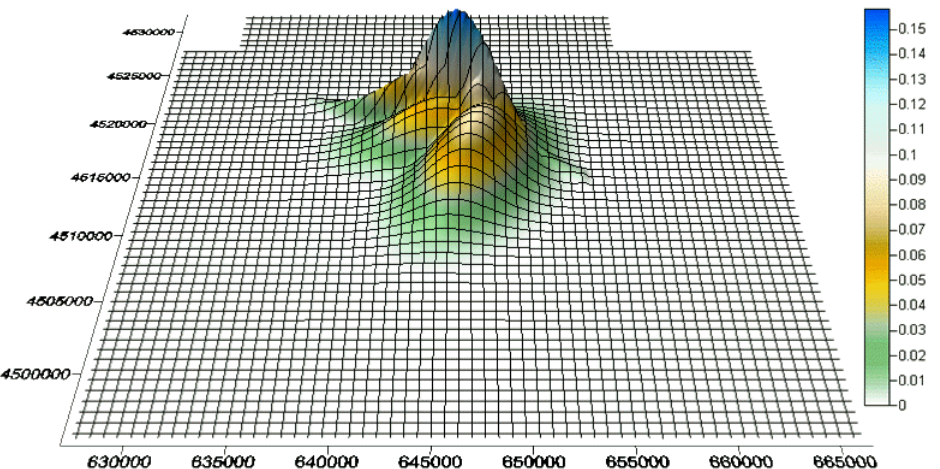
Figure 3. Union of the five UD s of the tracked lesser kestrels, i.e., the probability surface where each grid cell assumes the maximum value among all the surfaces of the probabilistic home ranges. On the X (easting) and Y (northing) axes, coordinates are expressed in meters. Probabilities are expressed in percentage.